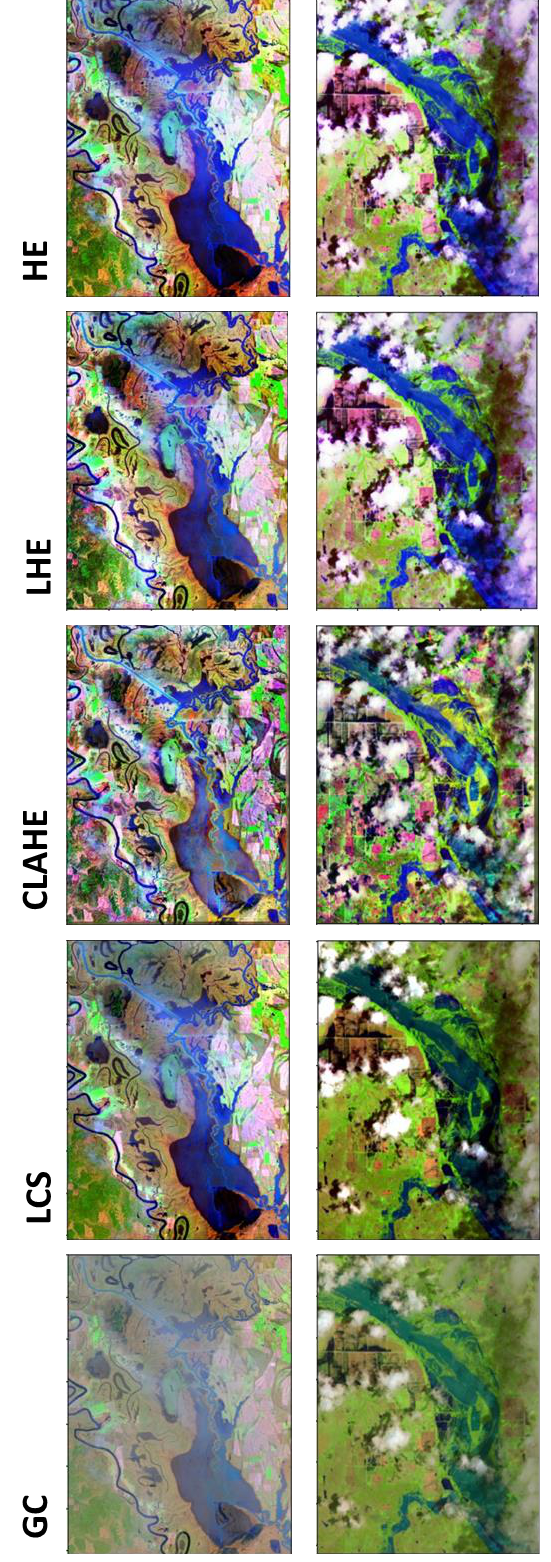
Figure 3. Output generated for two of the sixteen post-flood images using five image enhancement algorithms: Histogram Equalization (HE), Local Histogram Equalization (LHE), Contrast Limited Adaptive Histogram Equalization (CLAHE), Linear Contrast Stretch (LCS), and Gamma Correction (GC).